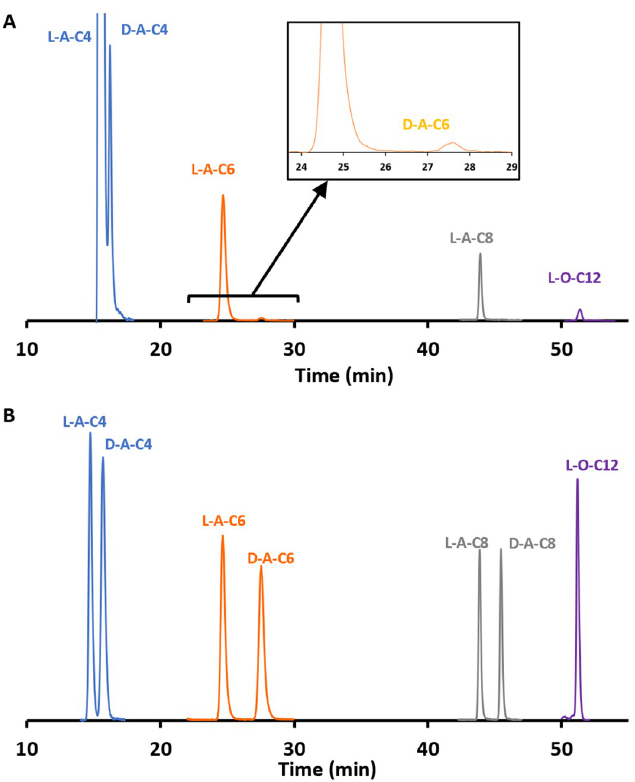
Fig 4. LC-MS/MS chromatogram with MRM transition to m/z = 102 showing the separation of most prominent N-HLs. (A) standard solution and (B) growth culture of P . aeruginosa . A-C4 and A-C6 were selected from 96 h growth and A-C8 and O-C12 were selected from 36 h growth. See method in experimental. Baselines normalized for clarity.